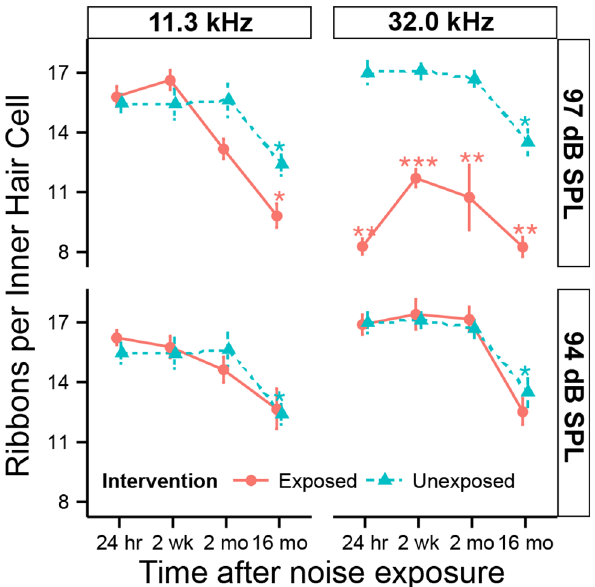
Fig 4. Numbers of presynaptic ribbons are reduced after neuropathic noise. Synaptic counts in inner hair cells in the 11.3 kHz (left) and 32.0 kHz (right) regions following exposure to neuropathic (97 dB SPL) or non-neuropathic (94 dB SPL) noise. Statistical significance of the group differences is indicated by asterisks: * : p < 0 . 05 , ** : p < 0 . 01 , *** : p < 0 . 001 . Data are group means ± SD. N = 6 – 7 animals per time and noise